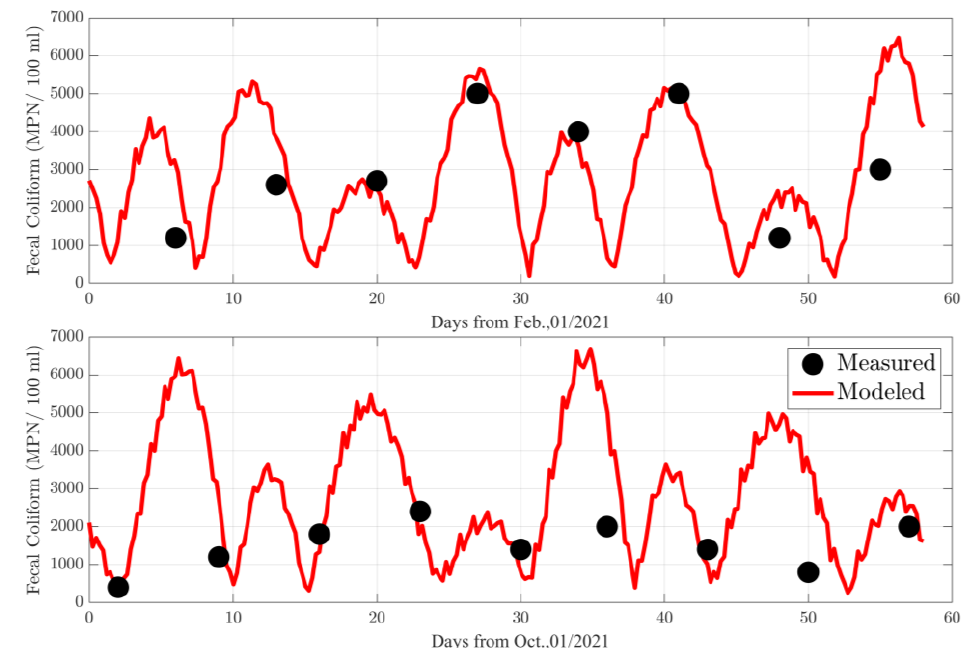
Figure 10. Comparison of fecal coliform concentration in the calibration and validation of the water quality model.